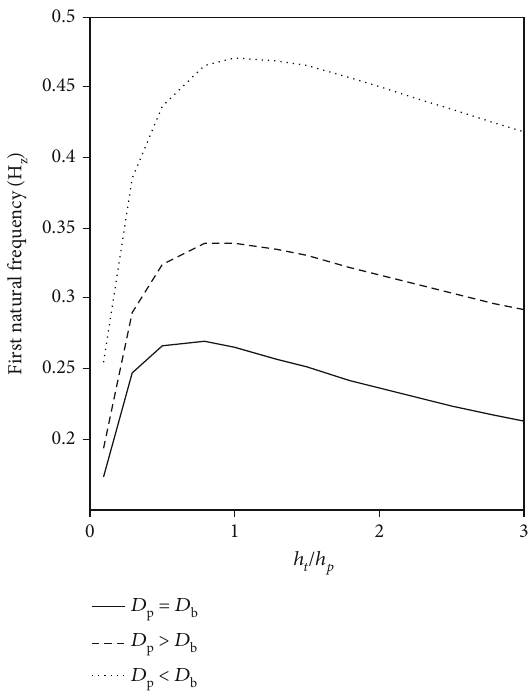
Figure 4: Natural frequency as a function of tower-to-pile thickness